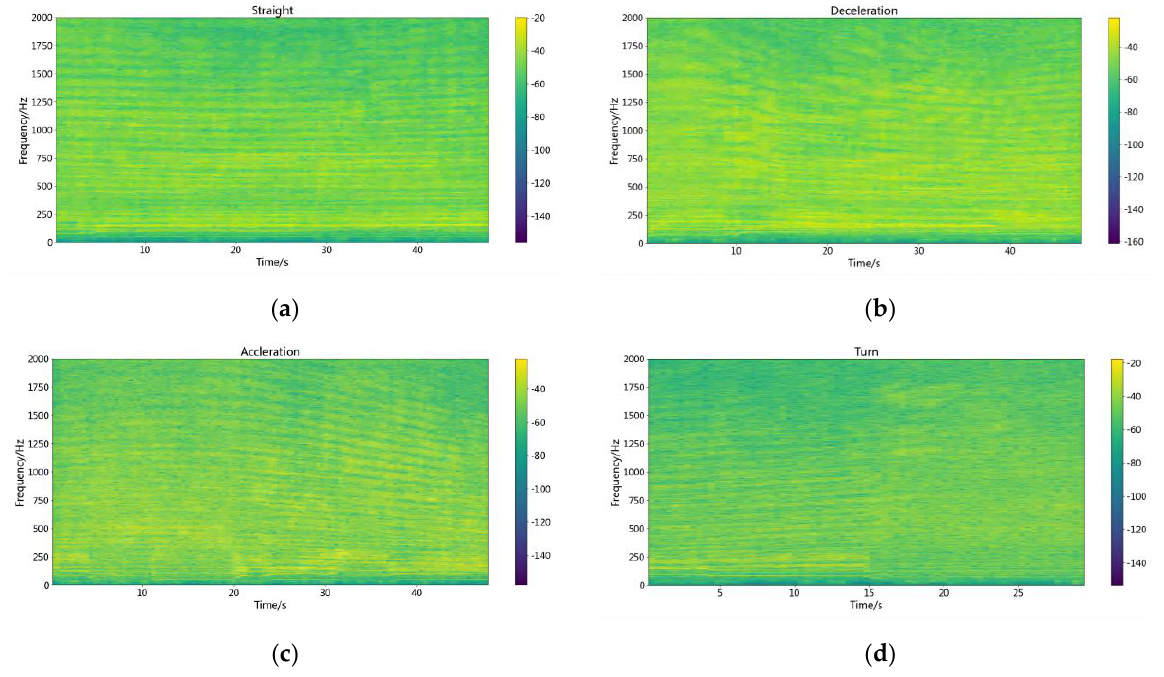
Figure 4. The spectrogram by the fourth type of vessel. ( a ) the spectrogram of straight motion. ( b ) the spectrogram of decelerating motion. ( c ) the spectrogram of accelerating motion. ( d ) the spectrogram of turning movement.